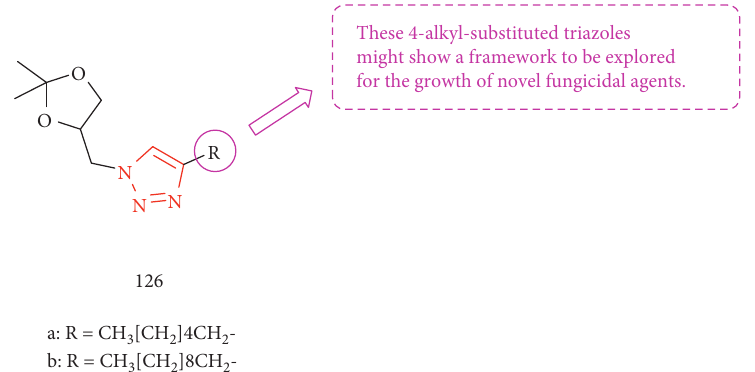
Figure 61: Chemical structure of glycerol triazolic